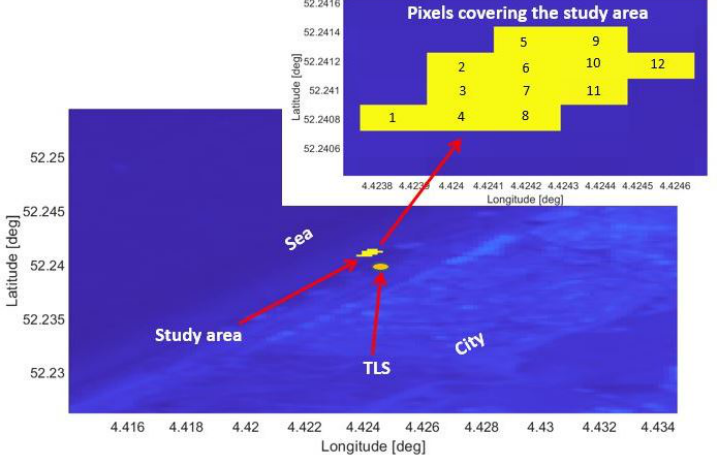
Figure 1. Location of the study site in Noordwijk, The Netherlands ( A ) with view of the Riegl VZ-2000 laser scanner mounted on the balcony of Grand Hotel Huis ter Duin ( B ) and point cloud colored with reflection ( C ) and indication of location of the laser scanner and study site.